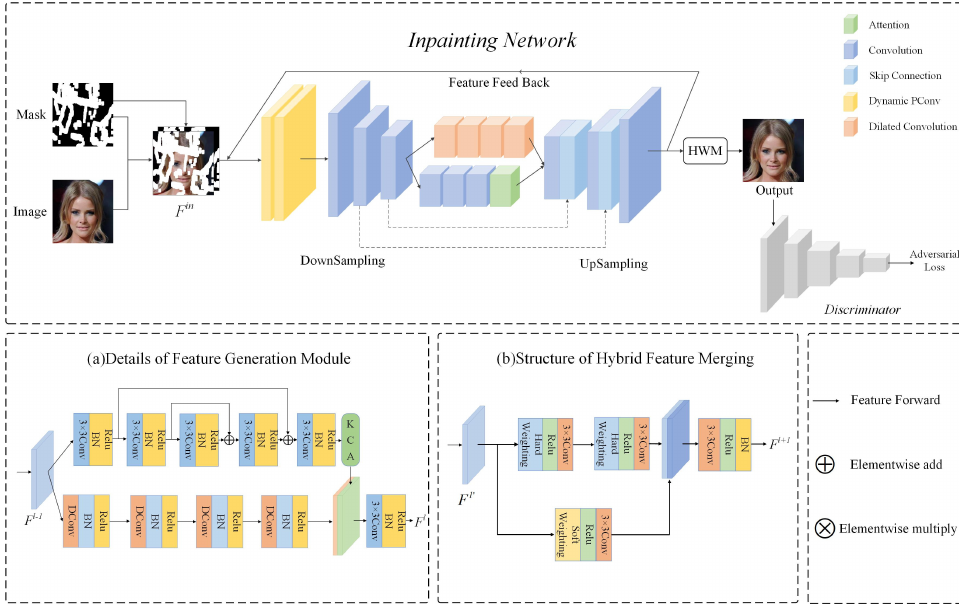
Figure 2. Illustration of our framework. Firstly, we use dynamic partial convolution to update the input mask m l , then use the inpainting network to generate the pixels for the missing areas. Next, the above operations are performed repeatedly to generate the feature maps of different inpainting stages. Finally, the feature maps of each stage are fused by using the Hybrid weighted merging to generate the repaired